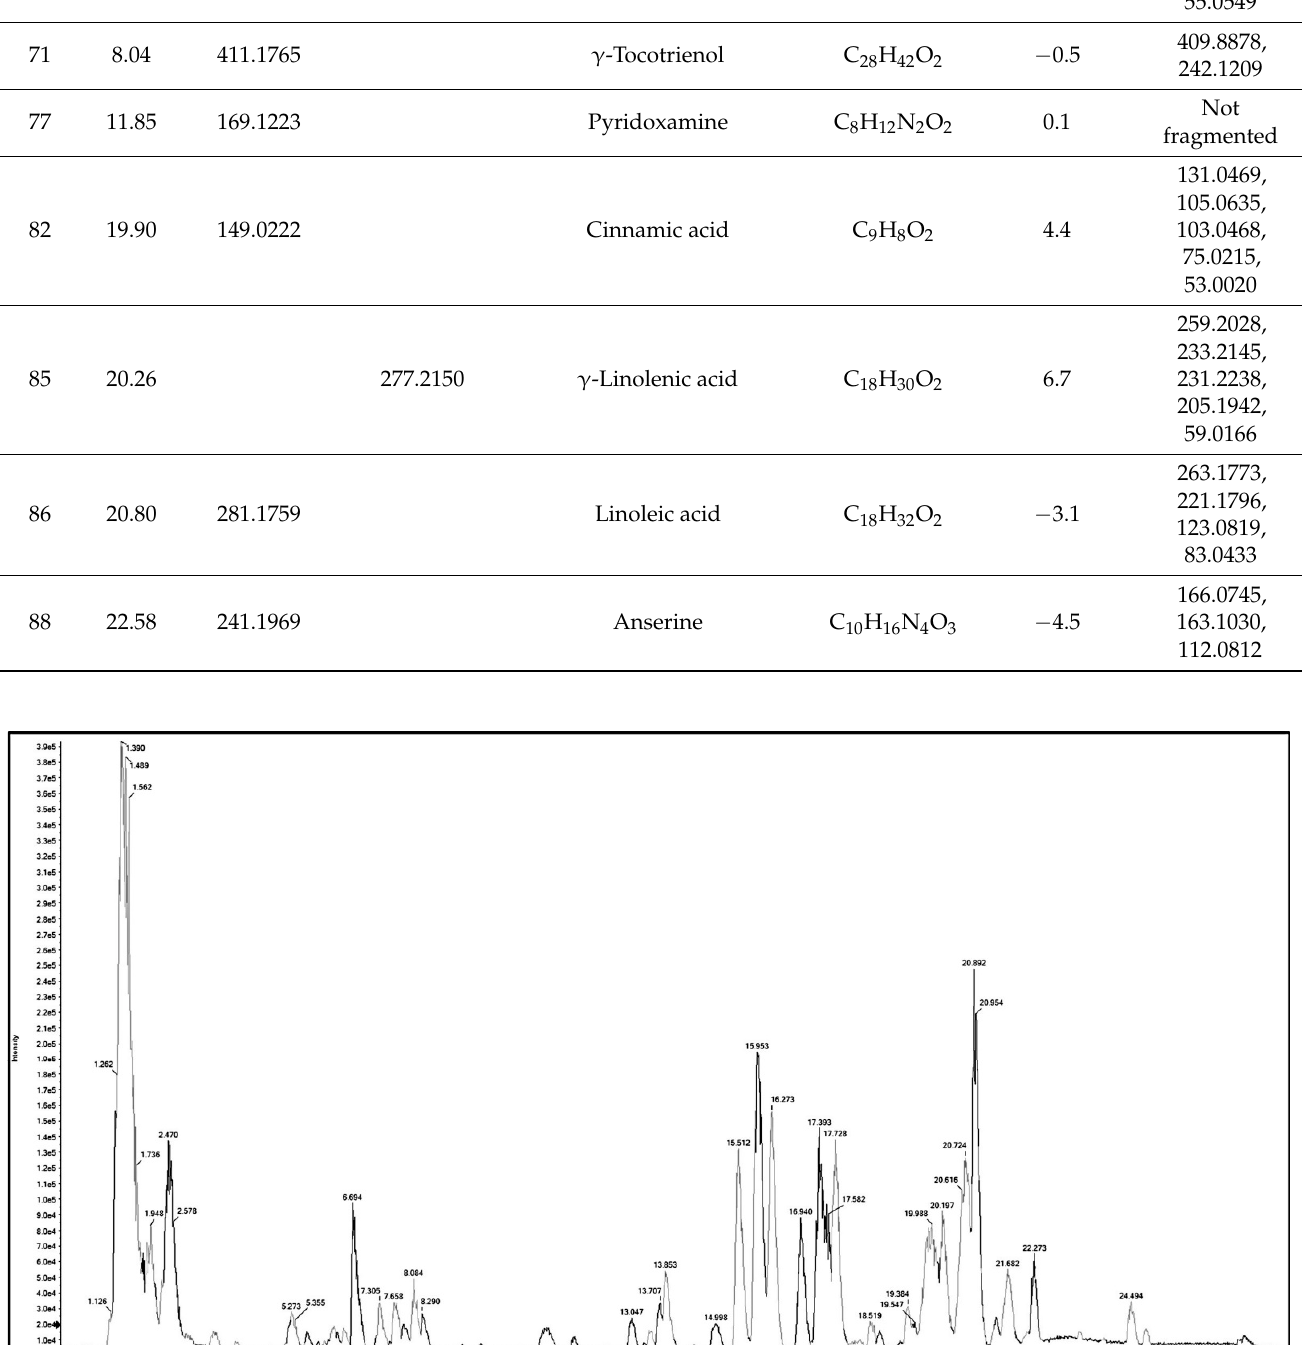
Figure 2. Base peak chromatogram (BPC) of Q-TOF LC/MS/MS analysis of B. armeniaca methanolic extract (BME) in negative mode. 2.2.1. Flavonoids There were 36 peaks assigned to flavonoids, all of which belonged to various sub- classes: flavonols, flavones, flavanonols, isoflavones, and flavanones. Eight flavone glyco- sides were characterized (peaks: 32, 38, 44, 51, 52, 54, 57, and 63), in addition to twelve flavonol glycosides (peaks: 34, 35, 39, 40, 42, 43, 47, 53, 56, 62, 65, and 81), two isoflavone